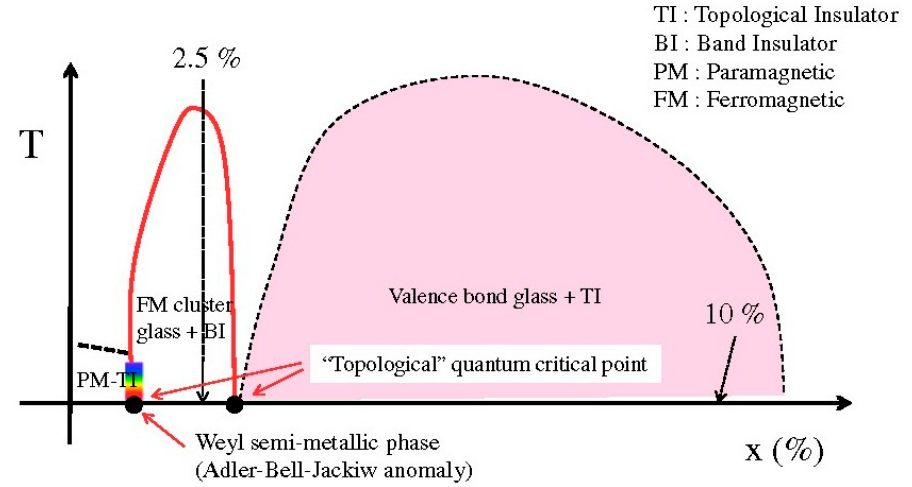
Figure 8. (Color online) Phase diagram and topological phase transitions of Fe x Bi 2 Te 3 [125].